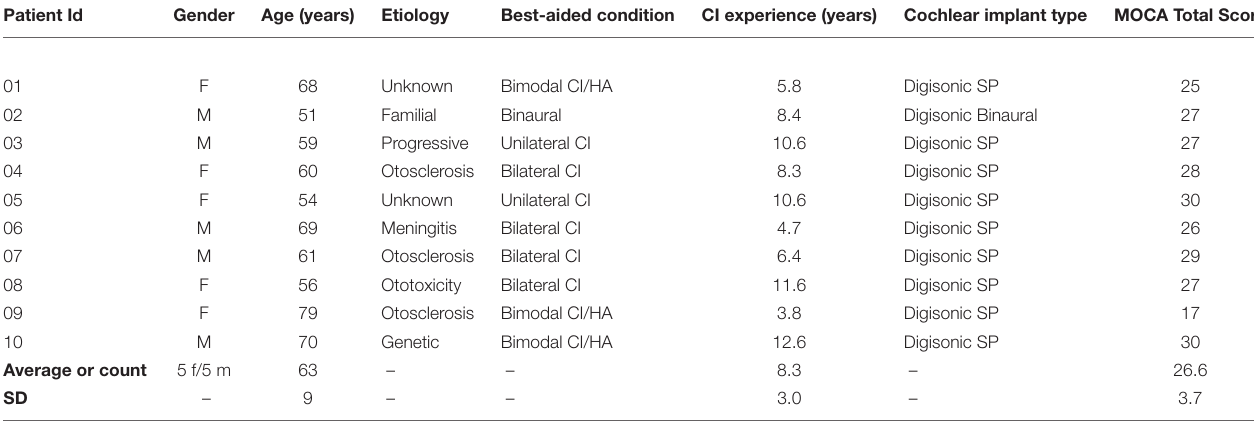
TABLE 1 | Patients’ demographics.